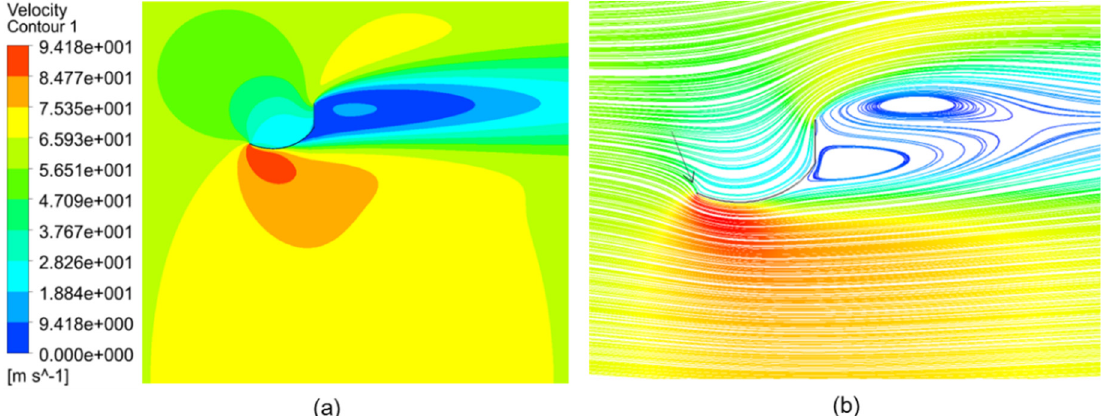
Figure 13. Flow fields around the flanged diffuser with a rigid flange (Figure 8a) at 60 m/s: ( a ) velocity contour and ( b ) streamline.